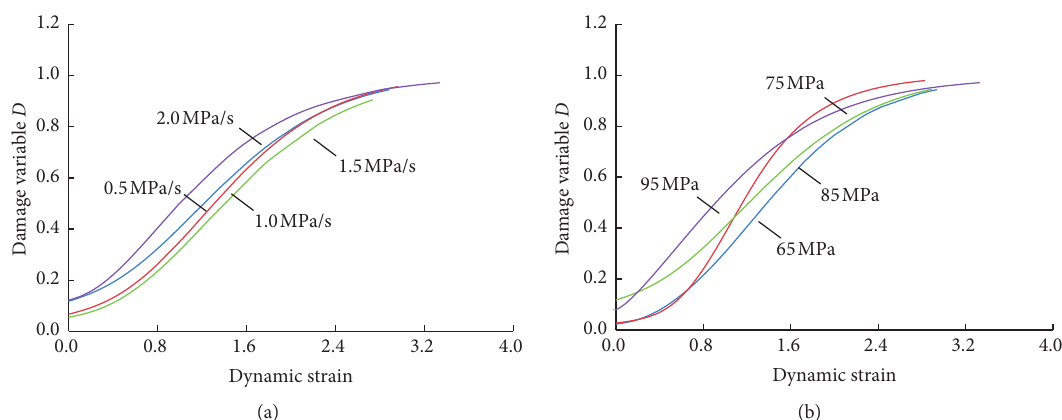
Figure 8: The damage variable-strain curves of rock under high static stress unloaded and frequent disturbances. (a) The axial pressure is 85MPa. (b) The unloading rate is 0.5MPa/s.